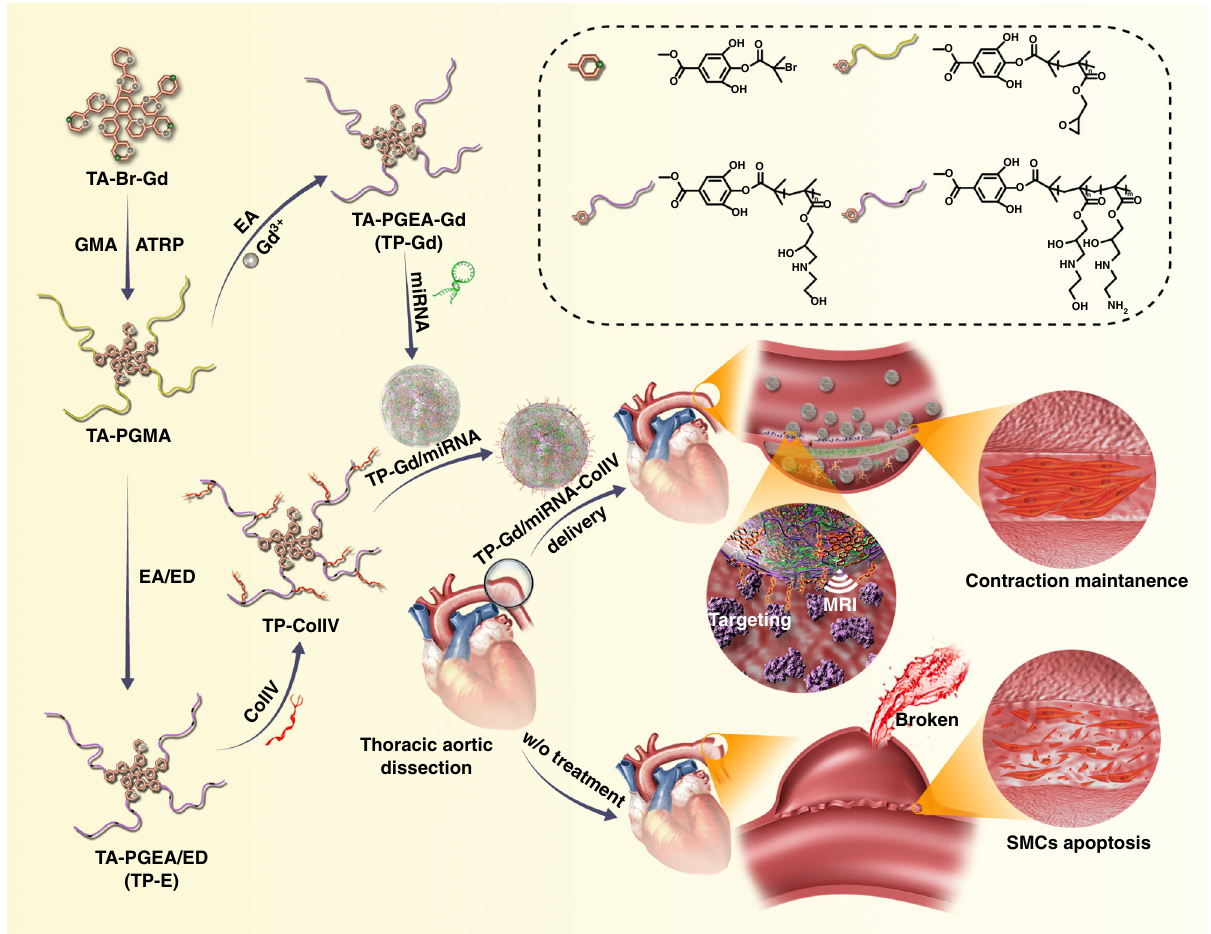
Fig. 1 Schematic diagram illustrating the preparation of TP-Gd/miRNA-ColIV complexes and the resultant targeted gene therapy of thoracic aortic dissection